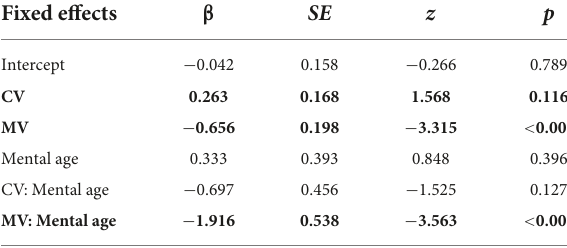
TABLE 7 Model for mental age exploration in the DS